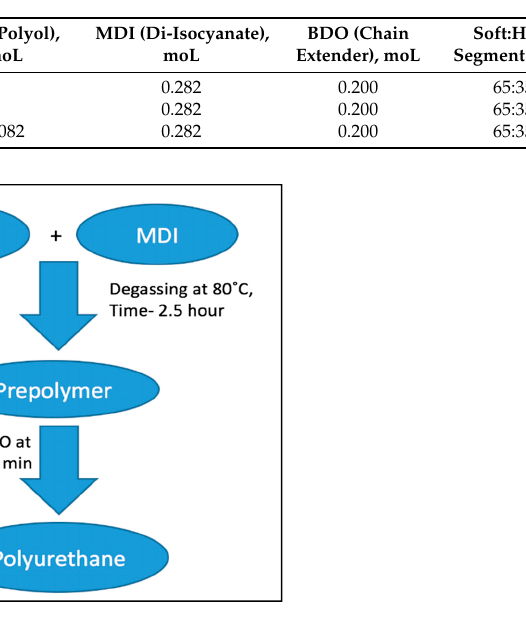
Table 2. Coding and thickness of uncoated and different coated fabric.